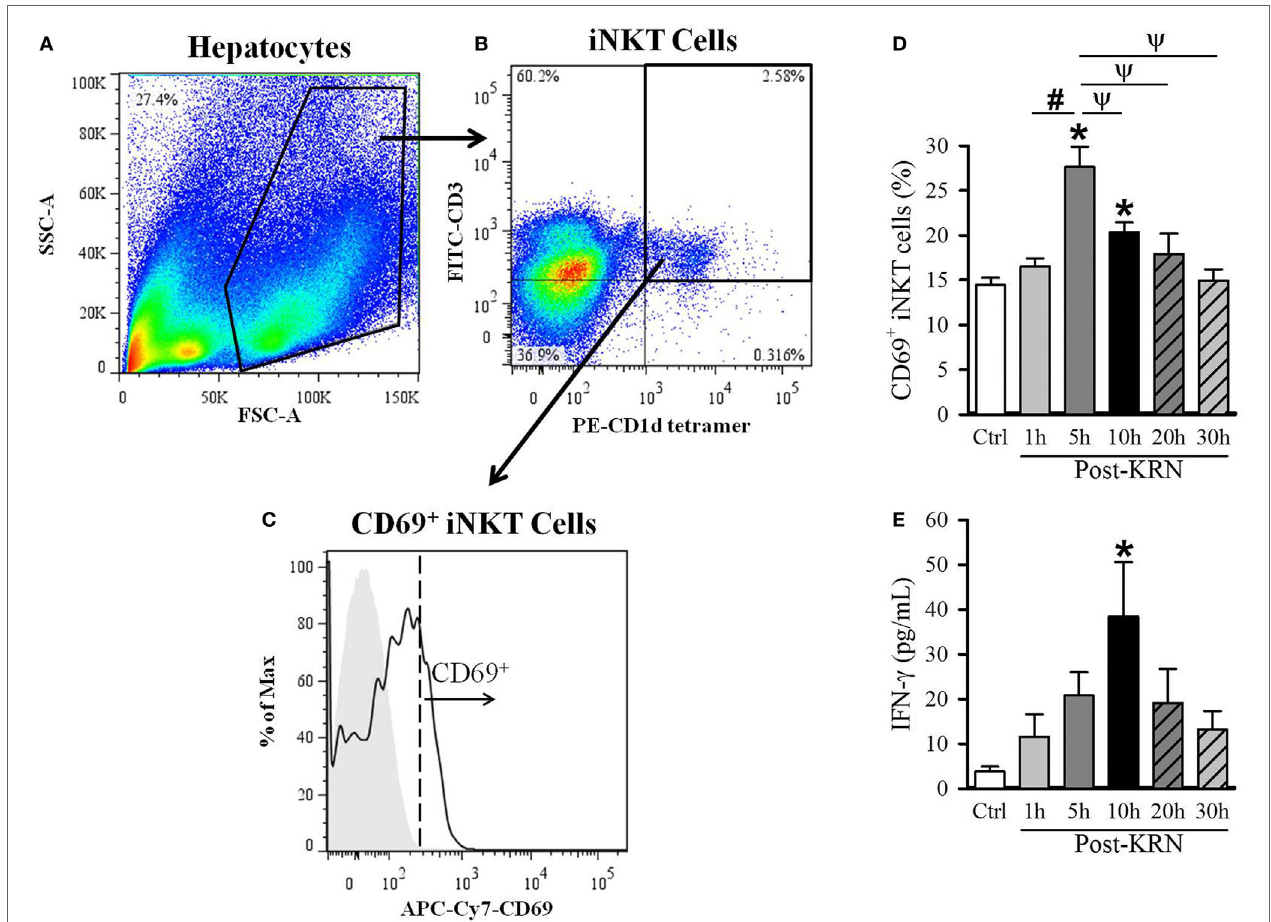
FigUre 2 | Kinetic analysis of KRN treatment on hepatic invariant natural killer T (iNKT) cell activation in neonatal mice. Serum and liver from C57BL/6 pups received KRN (0.2 µg/g BW) intraperitoneal were harvested at 1, 5, 10, 20, and 30 h after KRN administration or sham. Liver was dissociated through a 70-µm strainer to isolate hepatocytes, followed by staining and flow cytometry analysis. A representative sample showing flow cytometry gating strategy is shown. (a) Total cells isolated from the liver were gated for the live lymphocyte population based on forward scatter (FSC) and side scatter (SSC) characteristics. (B) The iNKT cell population was then identified by gating for the FITC-CD3 and PE-CD1d tetramer double-positive cell population. (c) Flow cytometric analysis of surface CD69 expression on the gated hepatic iNKT cells. Shaded area indicates negative control. (D) Flow cytometric analysis of surface CD69 expression on gated hepatic iNKT cells at each time point. (e) Interferon (IFN)- γ levels in the serum were measured by enzyme-linked immunosorbent assay at each time point. Data expressed as mean ± SEM ( n = 6–16 per group) and compared by one-way analysis of variance (* p < 0.05 vs. Ctrl, # p < 0.05 vs. 1 h, ψ p < 0.05 vs. 5